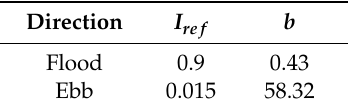
Table 1. Calibrated values of I ref and b